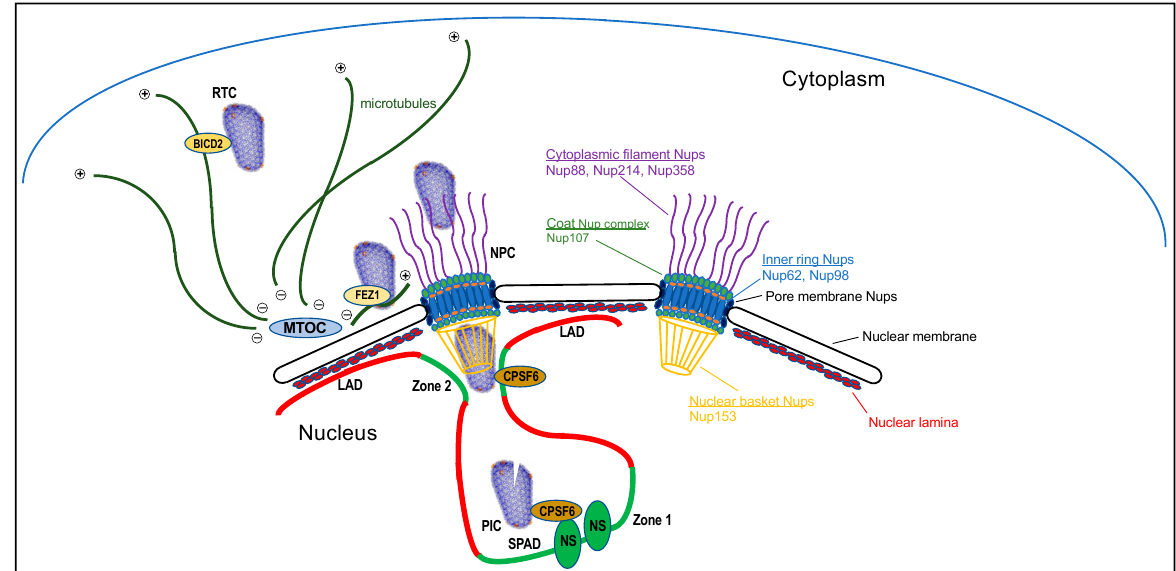
Figure 1. Intracellular HIV-1 trafficking to active genes for integration (not drawn to scale). The RTC, modeled after protein data bank (PDB) code 3J3Y (see Figure 2D), is shown interacting with a microtubule for retrograde transport via CA-binding protein BICD2. After reaching the microtubule organizing complex (MTOC), antegrade transport via kinesin-FEZ1 may shuttle the RTC to the NPC for nuclear transport. Nup proteins that have been shown to interact with CA are highlighted to the right, color coded to demarcate their relative positions within the NPC and noted subcomplexes. During nuclear entry, CPSF6 aids the release of the RTC from Nup153/the NPC nuclear basket [17]. Following nuclear entry, the preintegration complex (PIC) traffics to nuclear speckles (NSs) for integration into speckle-associated domains (SPADs) in a manner that is dependent on the CA-CPSF6 interaction [12]. Lacking this interaction, PICs mislocalize to the nuclear periphery and uncharacteristically target lamina-associated domains (LADs) for integration [15,18]. The PIC is depicted partially uncoated. Transcriptionally active Zone 1 and Zone 2 regions of chromatin are highlighted by green color [13].